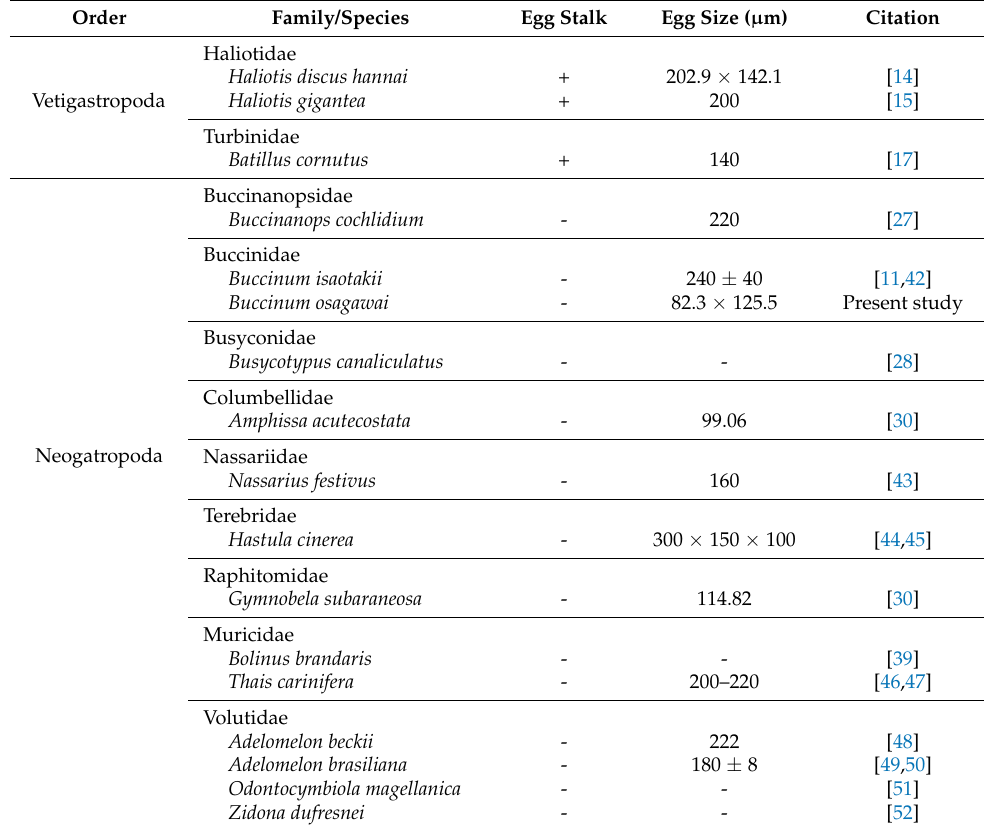
Table 3. The presence or absence of egg stalk and egg size in some